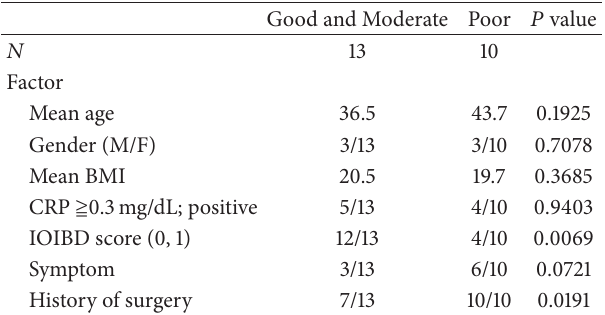
Table5:Comparisonsbetweenthegroupswithsmallbowelstenosis for affecting the category “Poor” on CE.